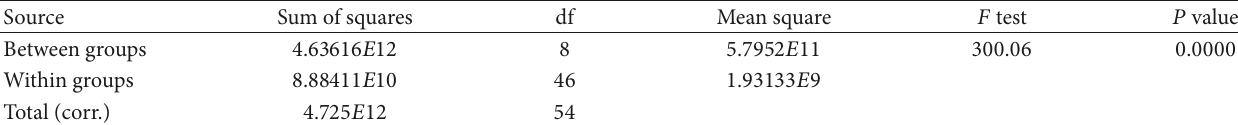
Table 4: ANOVA for profit by